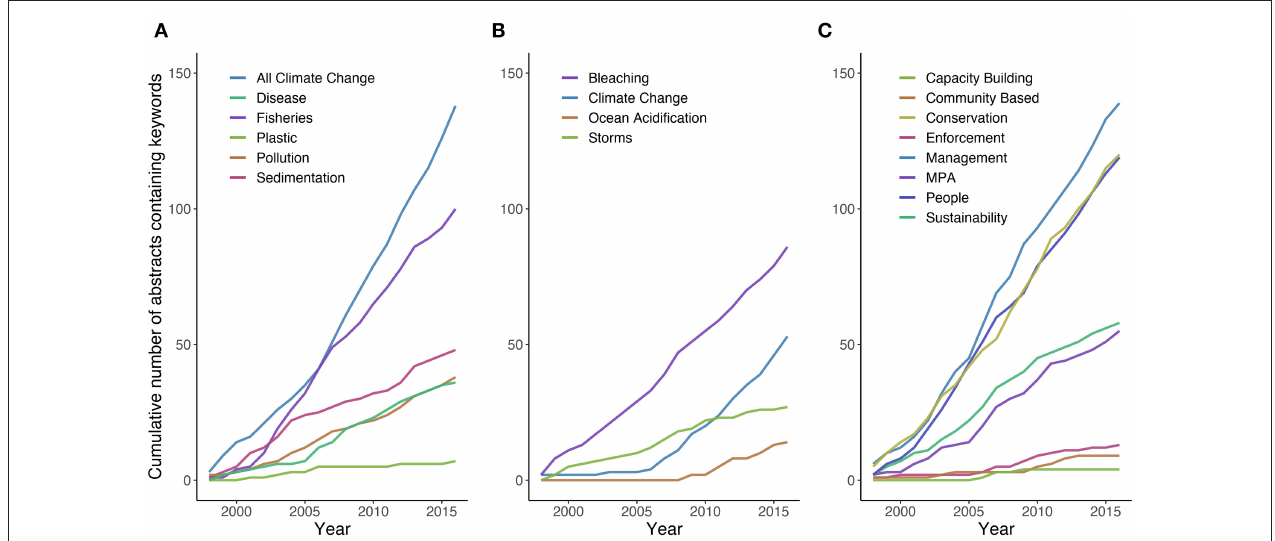
abstract contents (see Table 1 for keywords included in each